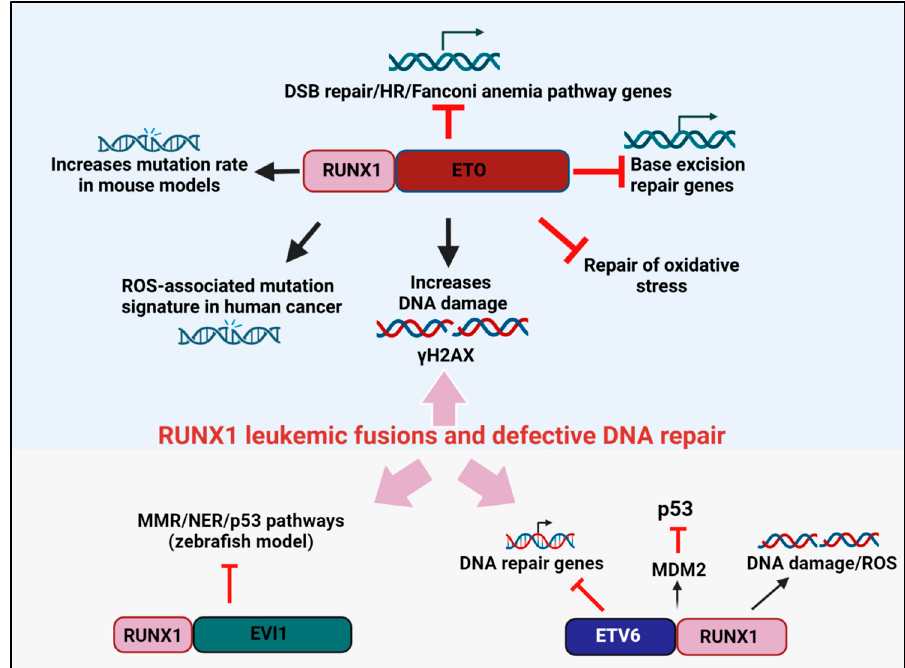
Figure 1. RUNX1 leukemic fusion proteins, DNA repair, and cancer. RUNX1-ETO attenuates the expression of genes involved in base excision repair, DSB repair, and the HR/FA pathways. RUNX1-ETO overexpression also reduces the efficiency of oxidative stress repair and induces the accumulation of γ H2AX marked DSBs. In mouse models, RUNX1-ETO expression elevates mutation rates, while in human cancers, RUNX1-ETO expression induces a ROS-associated mutation signature. The leukemogenic fusion protein ETV6-RUNX1 blocks the expression of DNA repair genes and attenuates p53 signaling by increasing MDM2 expression. RUNX1-EVI1 was shown to reduce the expression of genes involved in MMR and NER in a zebrafish model.